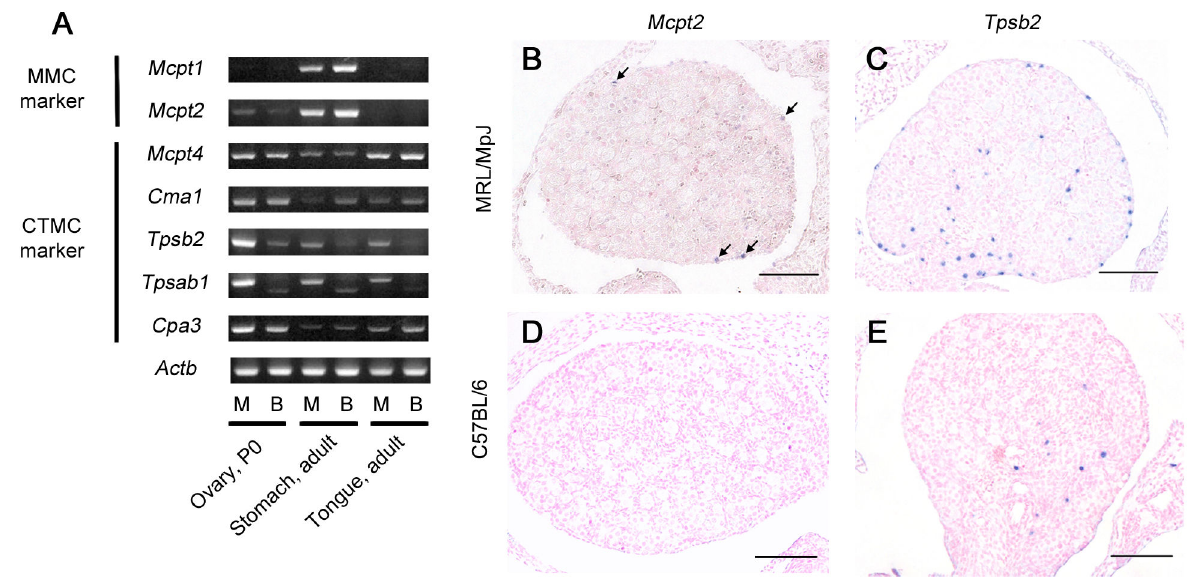
Figure 4. Gene expression of mast cell-specific proteases in the ovaries of neonatal mice. (A) RT-PCR was used to measure the mRNA expression of a mast cell (MC)-specific protease in the mouse ovary at postnatal day 0. Stomach and tongue samples from adult mice were used as positive controls for MMCs and CTMCs, respectively. Actb was used as an internal control. M: MRL/MpJ mice. B: C57BL/6 mice. (B–E) In situ hybridization of Mcpt2 and Tpsb2 in the ovaries at postnatal day 0. Mcpt2 - positive signals are detected in the surface epithelial region of the MRL/MpJ mouse ovary (panel B, arrows). No positive signal is observed in the ovaries of C57BL/6 mice (panel D). Tpsb2 -positive signals are detected in both strains (panels C and E) but are more abundant in MRL/MpJ mice (panel C). Bars: 100